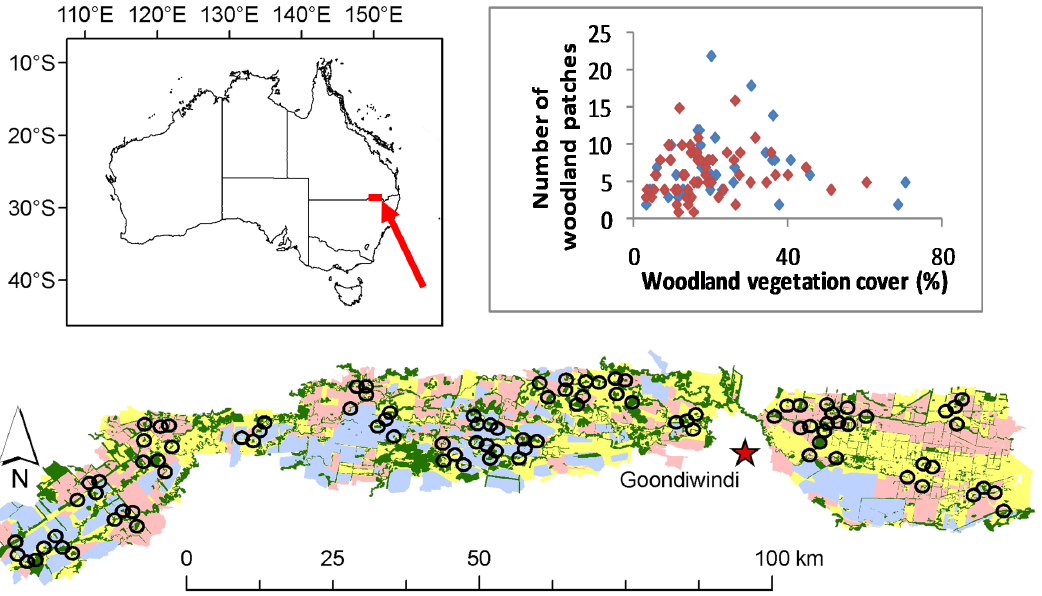
Figure 1. Location of the study area in southern Queensland (red arrow), and location of the 96 study landscapes (1 km radius) in relation to the nearest township of Goondiwindi, as indicated by a star, and the Queensland border along the Macintyre River. Green shading represents woodland vegetation, irrigated land-use shown in blue, dryland land-use shown in pink and pastoral land-use shown in yellow. Also a scatter plot displaying the relationship between the extent and subdivision of woodland habitat within study landscapes, with sites colonized by Manorina honeyeaters shown in red and sites where colonies are absent shown in blue.